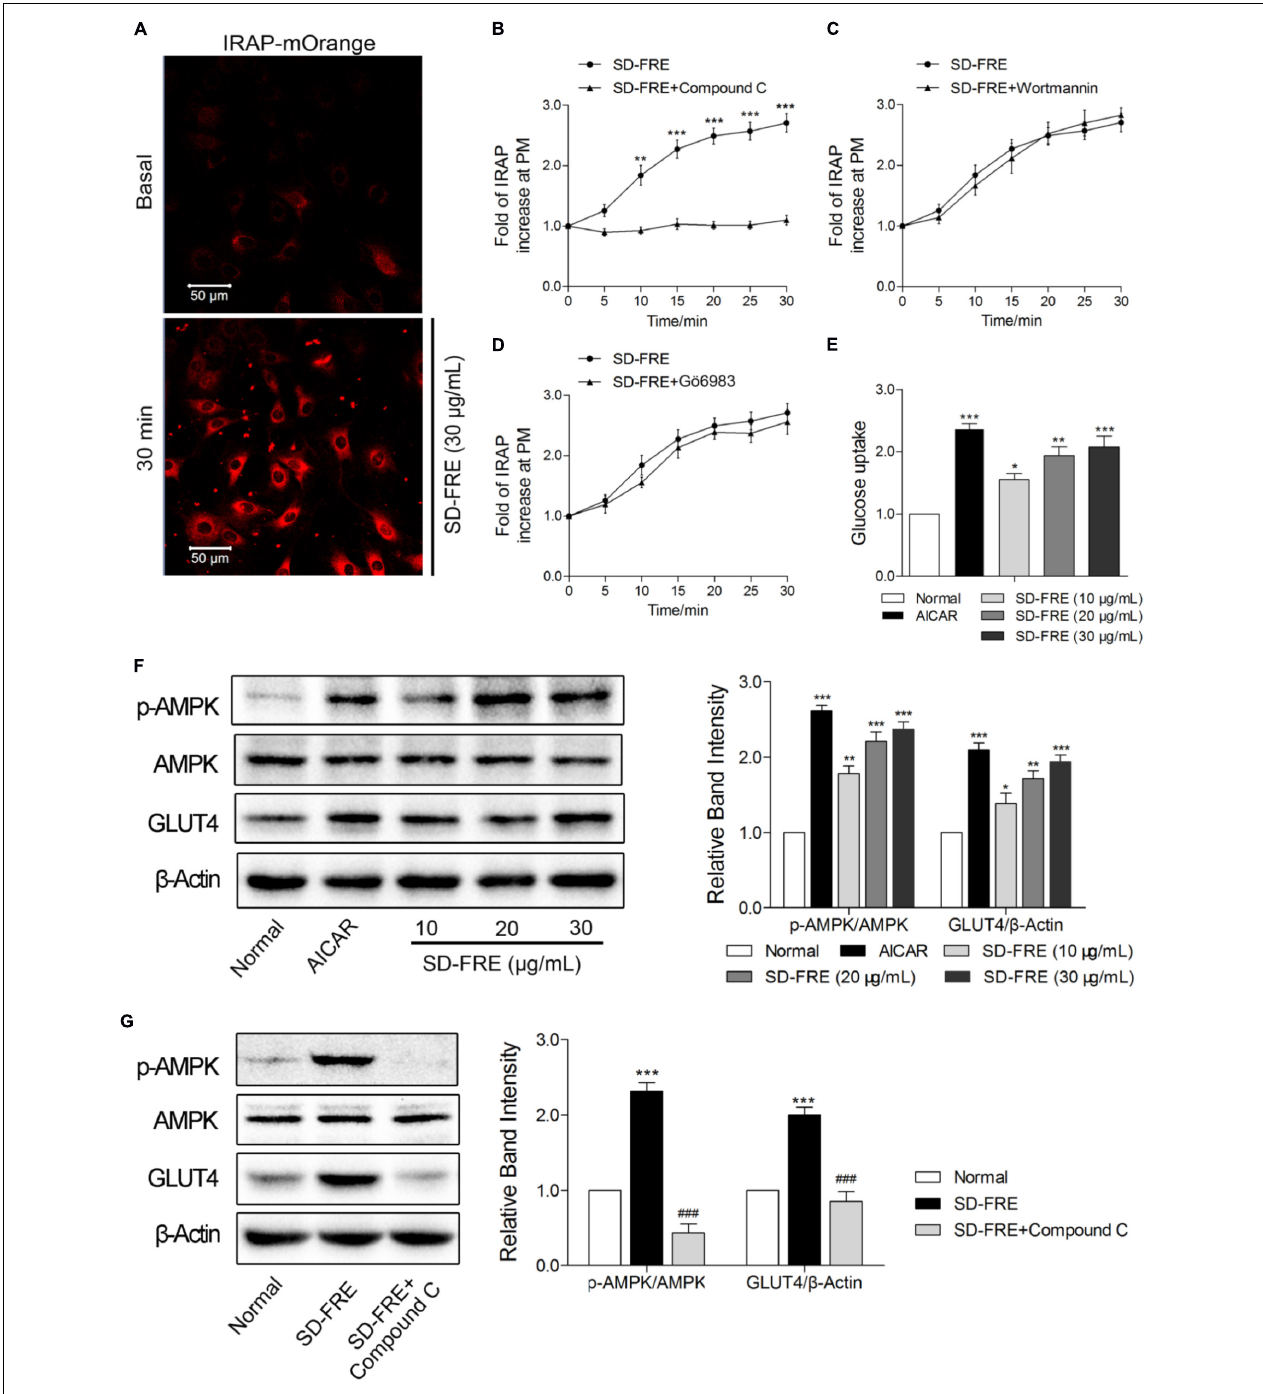
FIGURE 2 | Effects of SD-FRE in vitro . (A) IRAP fluorescence in L6 IRAP-mOrange was measured by confocal microscope. Following the addition of SD-FRE (30 µ g/mL), IRAP fluorescence intensity at the plasma membrane was increased significantly at 30 min. Scale bar, 50 µ m. (B–D) Time course of the change in fluorescence induced by SD-FRE with inhibitors (Compound C, Wortmannin, Gö6983) between 0 and 30 min. ∗∗ P < 0.01, ∗∗∗ P < 0.001 compared with SD-FRE + Compound C. (E) Glucose uptake was measured by 2-NBDG assay. AICAR and SD-FRE (10, 20, and 30 µ g/mL) increased glucose uptake, respectively. ∗ P < 0.05, ∗∗ P < 0.01, ∗∗∗ P < 0.001 compared with control. (F) AICAR and SD-FRE (10, 20, and 30 µ g/mL) induced increases in AMPK phosphorylation and GLUT4 expression in L6 cells. ∗ P < 0.05, ∗∗ P < 0.01, ∗∗∗ P < 0.001 compared with normal. (G) Compound C inhibited the SD-FRE (30 µ g/mL) induced AMPK phosphorylation and GLUT4 expression. Data are mean ± SEM, shown as relative band intensity compared with normal control ( n = 3). ∗∗∗ P < 0.001 compared with normal, ### P < 0.001 compared with SD-FRE group.